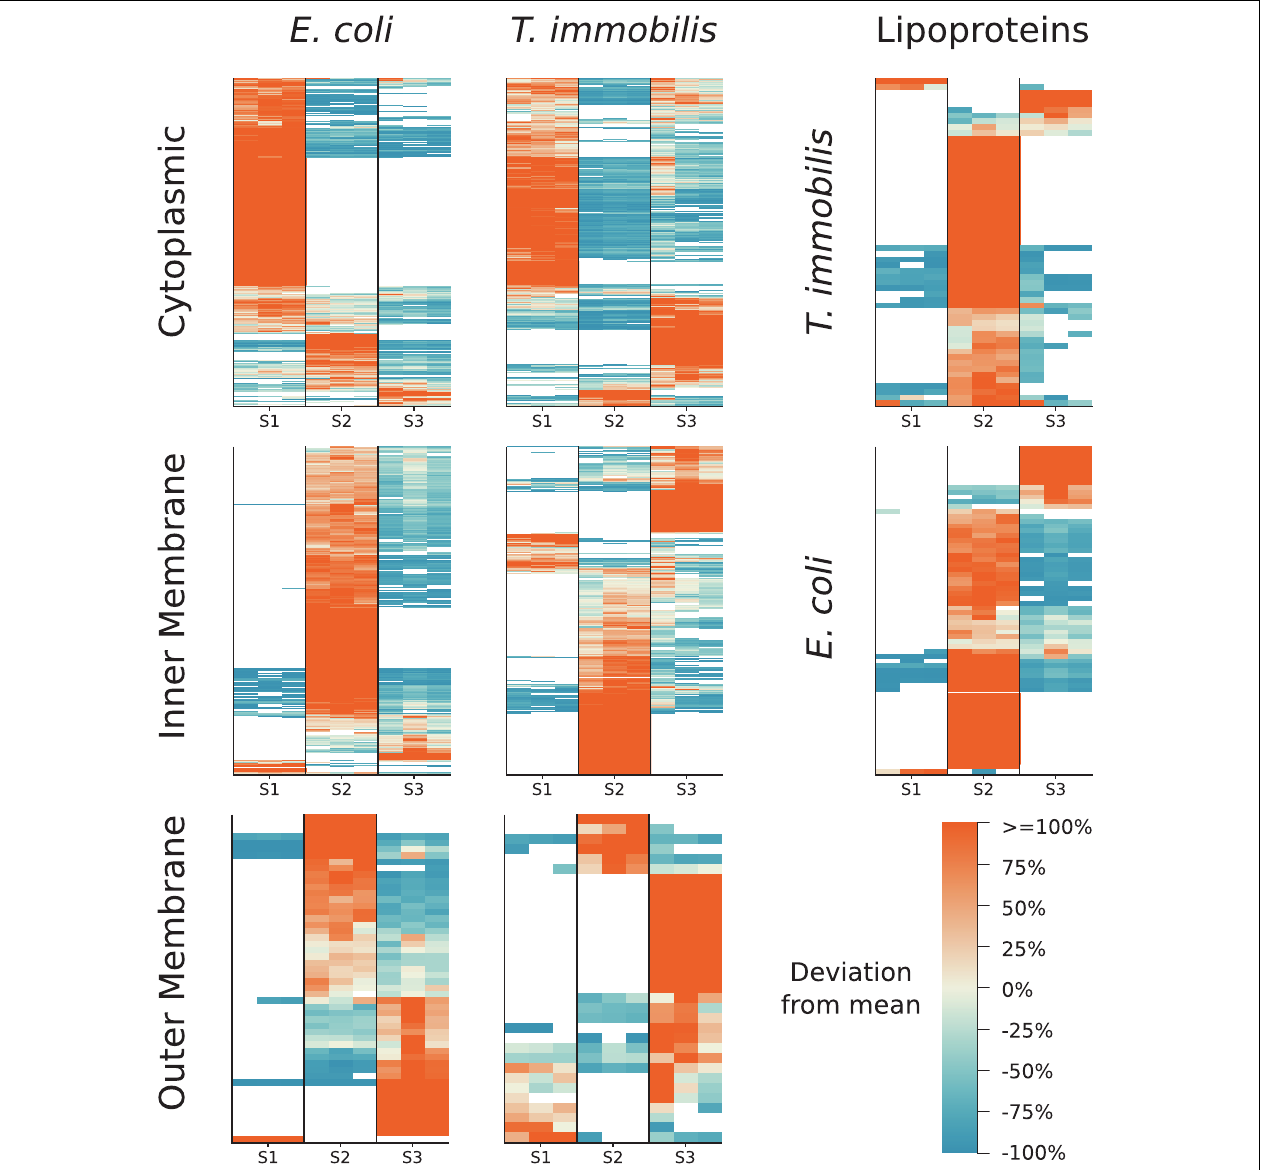
FIGURE 4 | Subcellular localization predictions and relative abundance for T. immobilis and E. coli subcellular proteomes. Heatmaps for each species illustrate the relative abundance of predicted cytoplasmic, inner/cytoplasmic membrane, outer membrane proteins and lipoproteins as a function of the subcellular fraction [Tris soluble (S1), Tris/TX-100 soluble (S2), Tris/SDS soluble (S3)]. Proteins exclusively found in one fraction were colored as though they deviated from the mean by 100%. PSORTb v3.0 was used to predict cytoplasmic, inner membrane and outer membrane proteins. In addition, BOMP was used to complement outer membrane predictions. LipoP v1.0 was used to predict